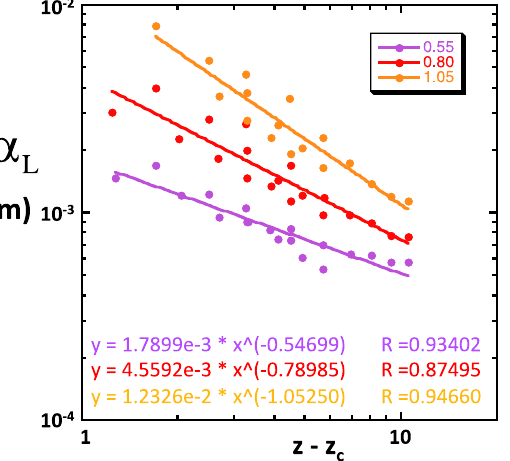
Figure 2. Approximately “universal” power law relationships of the simulated dispersivities with Z − Z c in networks realizations with CV ≥ 0.55 (indicated using the same colors as in Fig. 1). The clusters of data- points include SC, BCC and FCC simulations. The data-point scatter helps visualize the statistical uncertainty associated with each value of CV . The best fitting equations are indicated in matching colors. The simulations corresponding to CV = 0.05 and 0.30 are omitted because they produce results that depend on lattice type (see